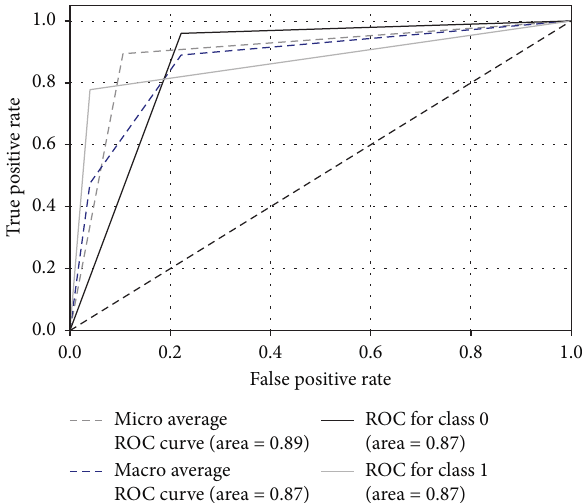
Figure 6: ROC curve for testing data using DT